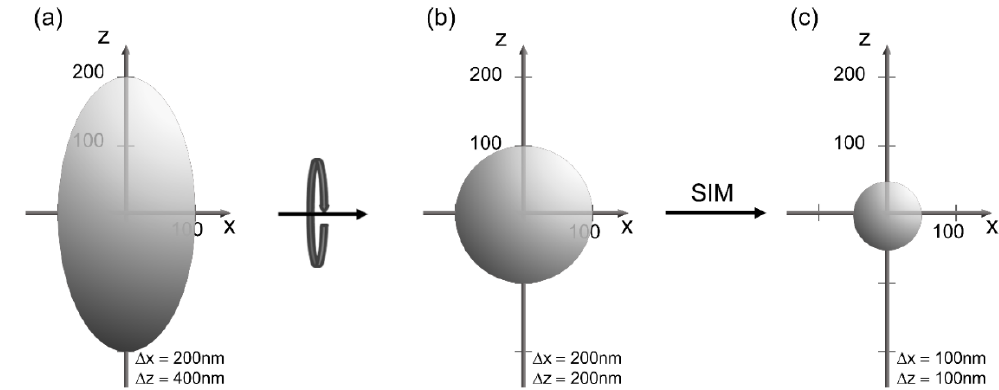
Figure 4. Point spread function for high resolution wide-field microscopy ( a ), axial tomography ( b ) and a combination of axial tomography with Structured Illumination Microscopy (SIM) ( c ).